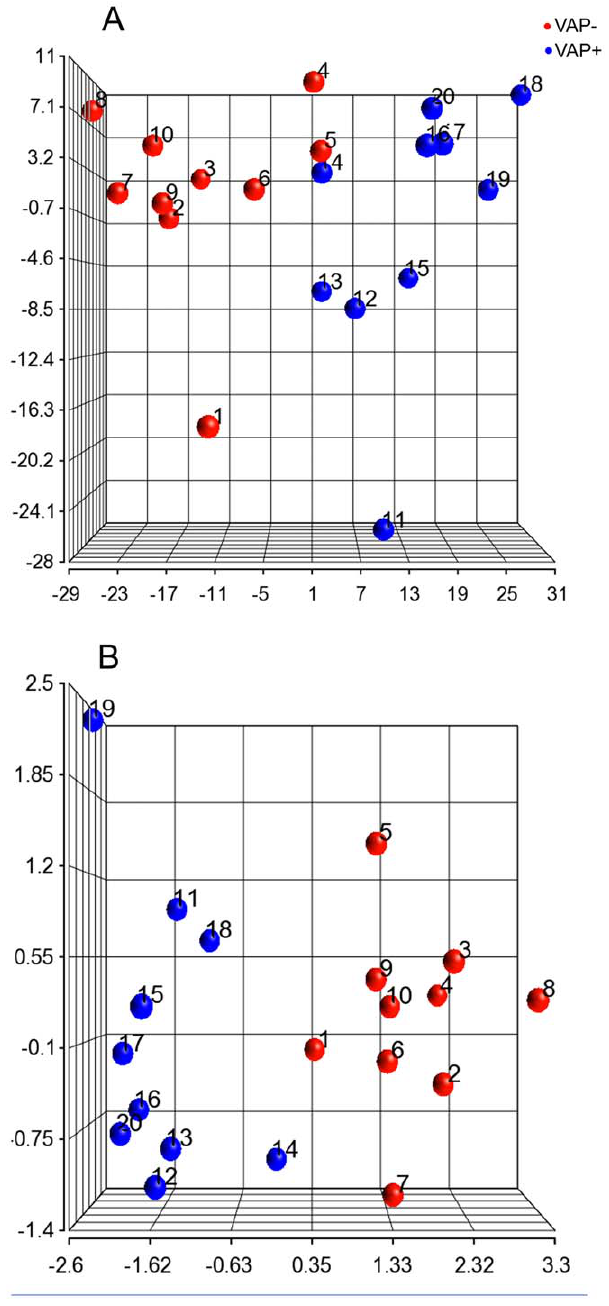
Figure 2. Principal component analysis for VAP 2 and VAP + patients. (a) Sample clustering of patients that went on to develop ventilator-associated pneumonia (blue) and those that did not (red) using principal component analysis of 810 differentially expressed genes. (b) Sample clustering of patients that went on to develop ventilator-associated pneumonia (blue) and those that did not (red) using principal component analysis of 5 genes that were common to all sets in the cross validation